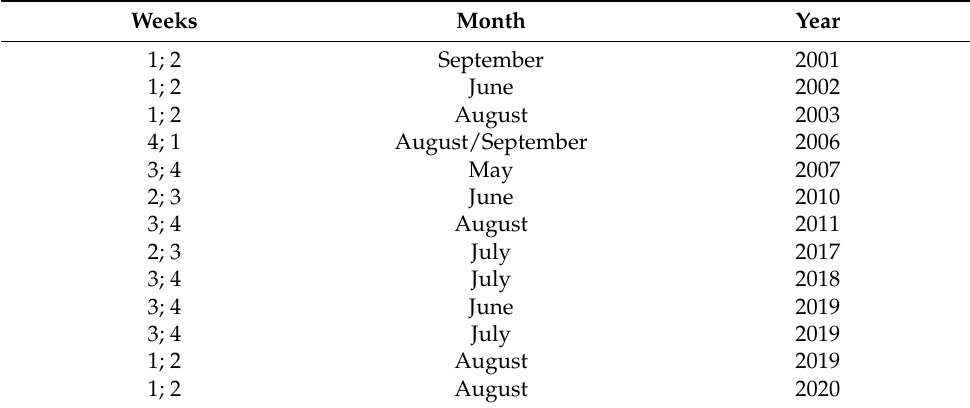
Table 3. Heat anomalies in Europe for the period 2000–2020.